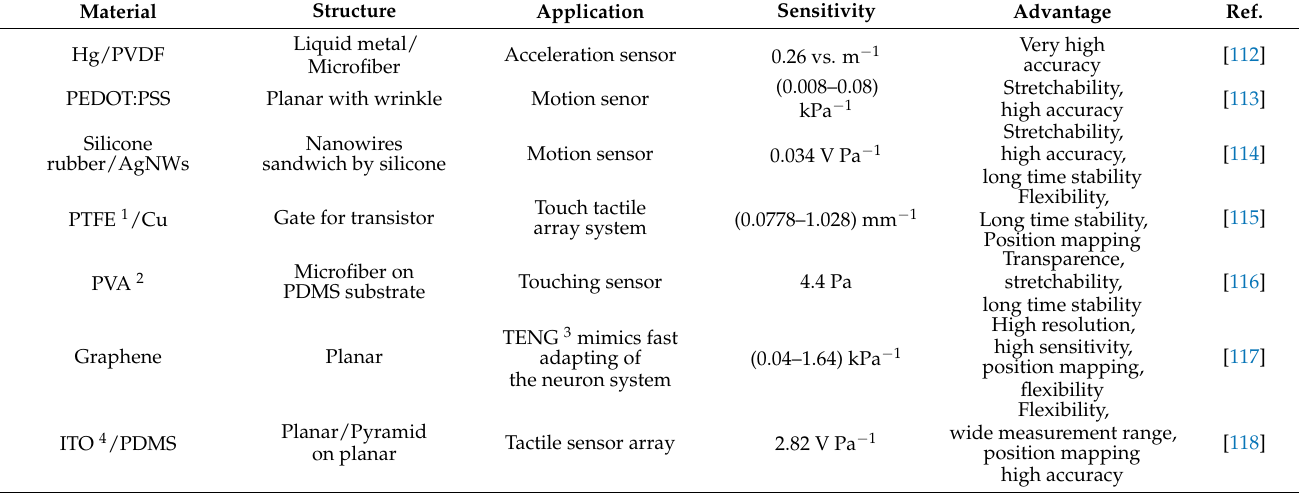
Figure 6. ( a ) Waterproof and stretchable triboelectric tactile sensor [108]. ( b ) Silver-coated nylon yarn on silicone rubber for skin-inspired triboelectric [109]. ( c ) Single-electrode based sliding triboelectric for vector sensor [110]. ( d ) Sliding mode triboelectric by charge space-accumulation effect [111]. Table 4. Comparative sensing performances of the triboelectric-based sensor.